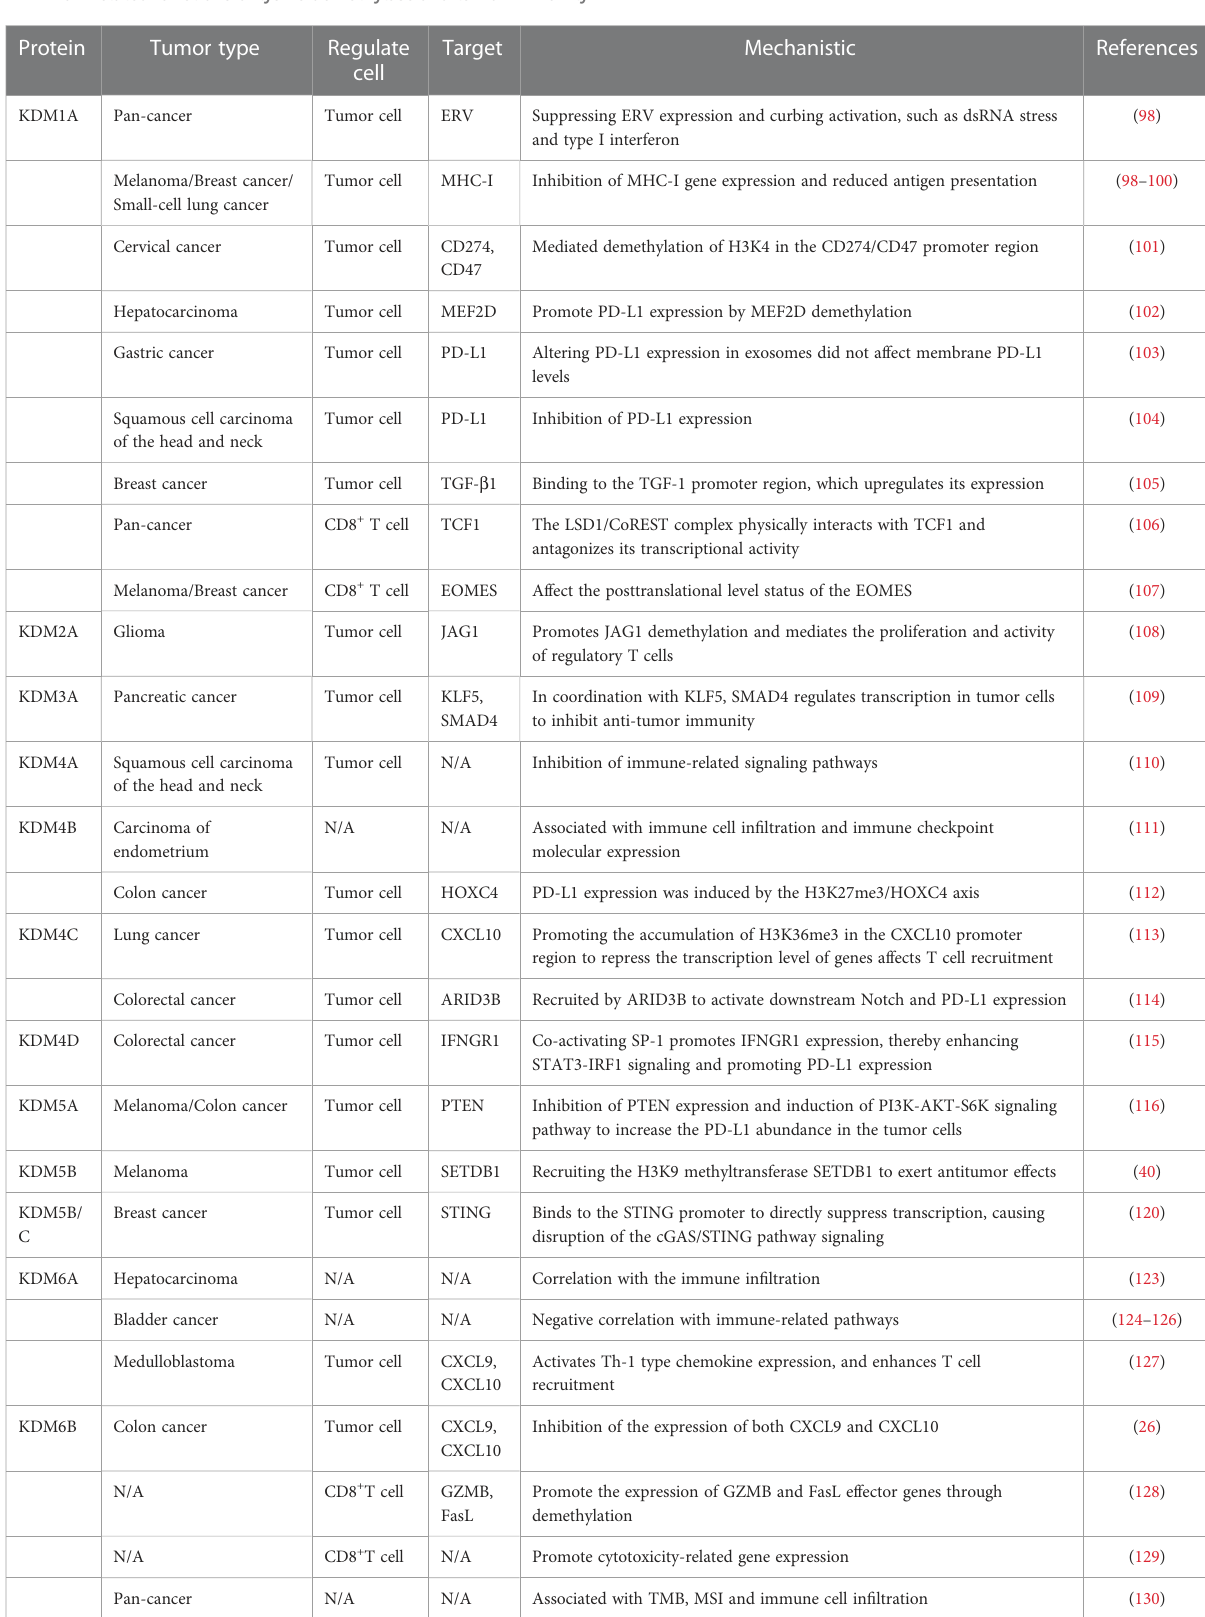
TABLE 3 Related functions of lysine demethylase and tumor immunity.